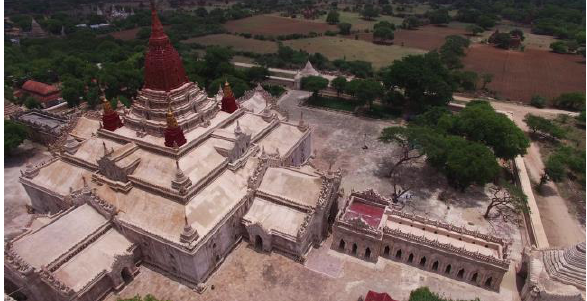
Figure 2 Ananda-gu-hpaya-gyi temple, Bagan. Photo taken with a drone DJI Inspire 1. Image Source: Scott Lee. The collaboration with intergovernmental organizations, private foundations, governments, and consulting companies, has provided the adequate knowledge and experience for the following contribution.